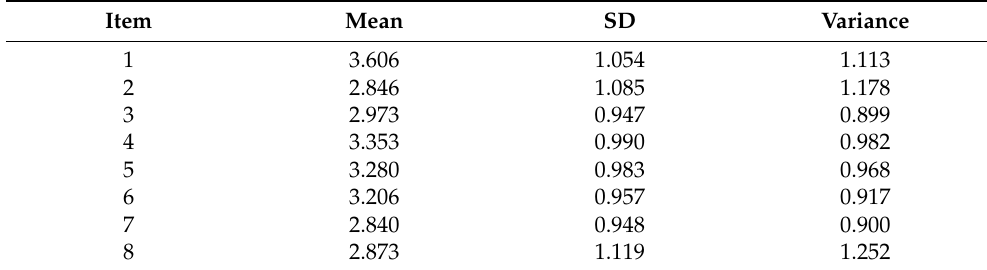
Table 2. Descriptive statistics of items.